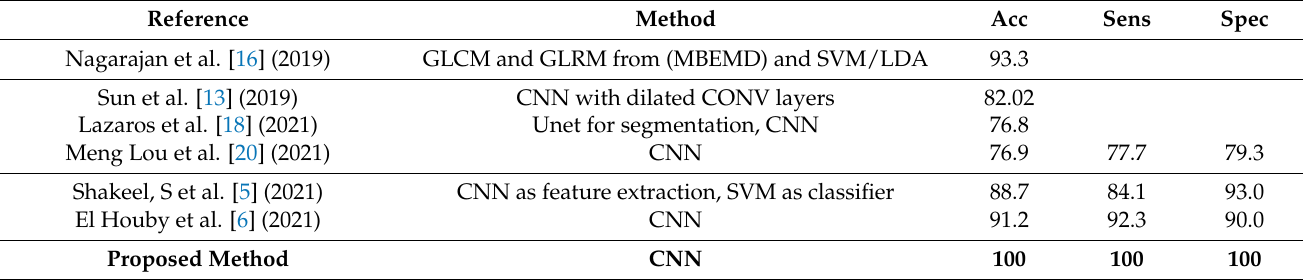
Table 6. Performance comparison between proposed method and state-of-the-art on DDSM